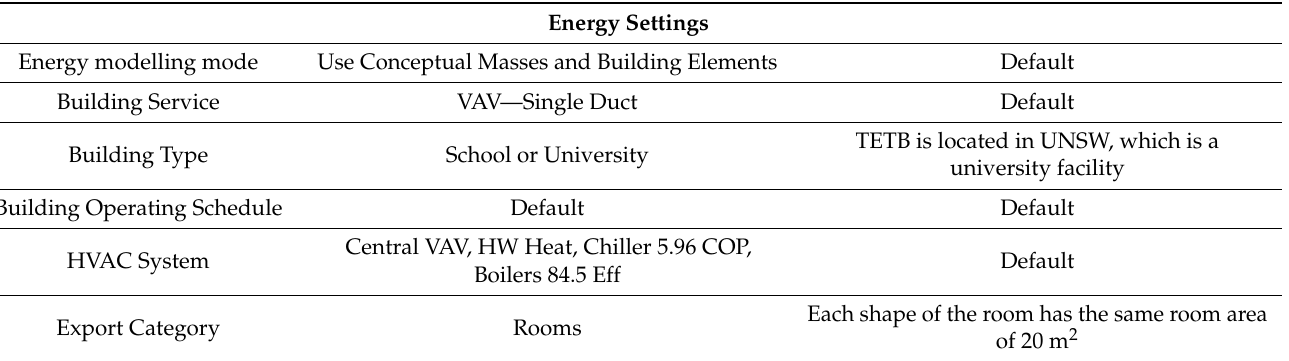
Table 4. Summary of energy simulation settings.